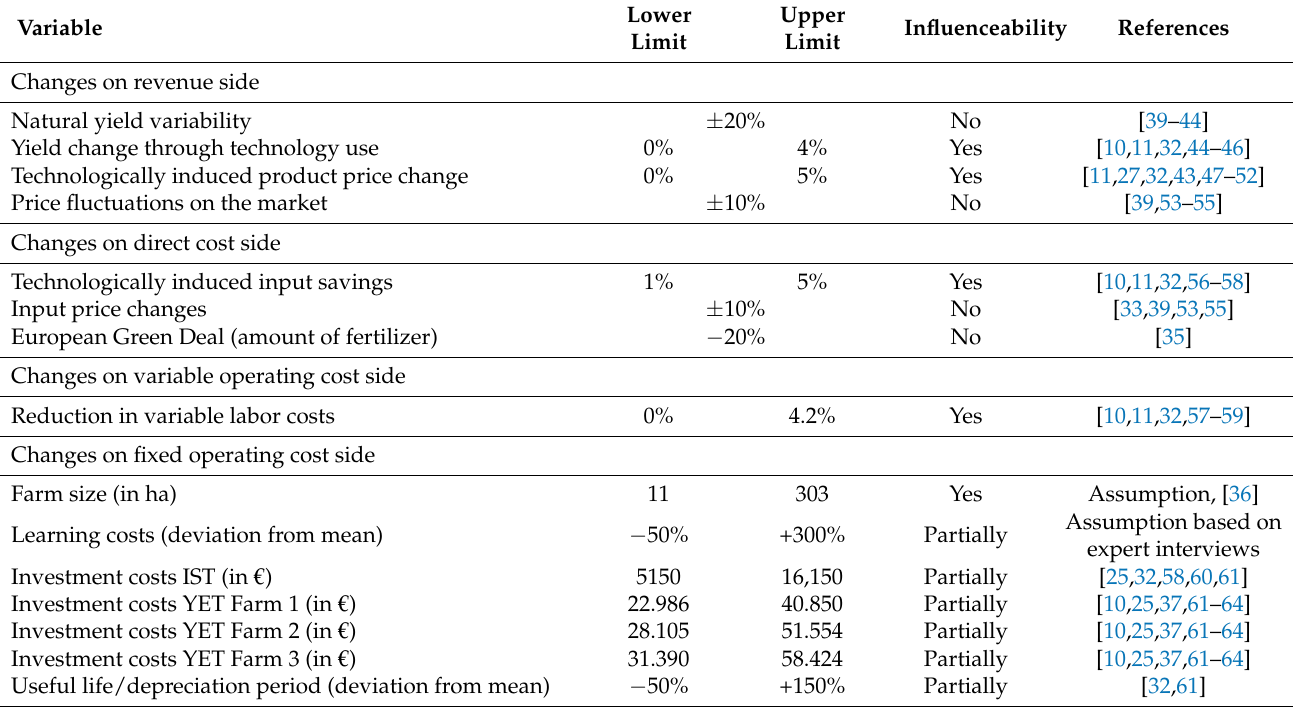
Table 1. Range of data used and ability of the farmer to influence the